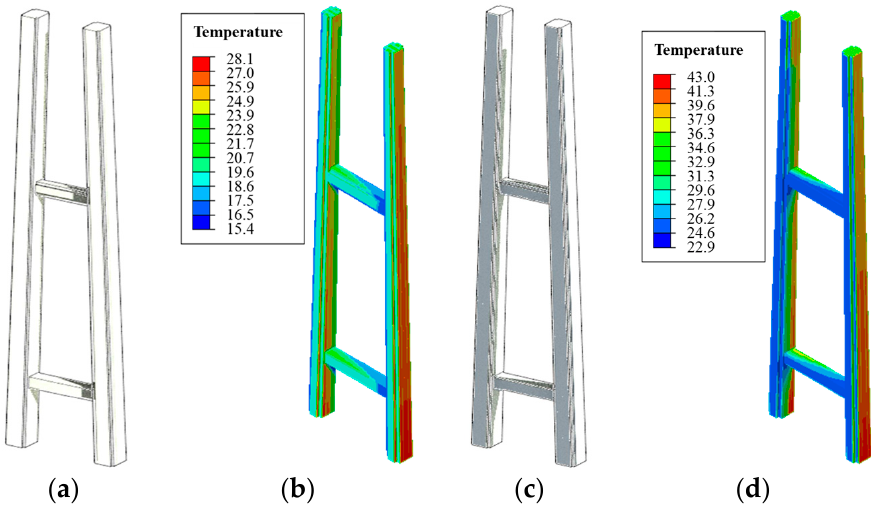
Figure 9. Validation of 3D temperature field simulation: ( a ) Natural sunlight rendering in spring. ( b ) Calculated temperature field of pylon temperature in spring. ( c ) Natural sunlight rendering in summer. ( d ) Calculated temperature field of pylon temperature in summer.